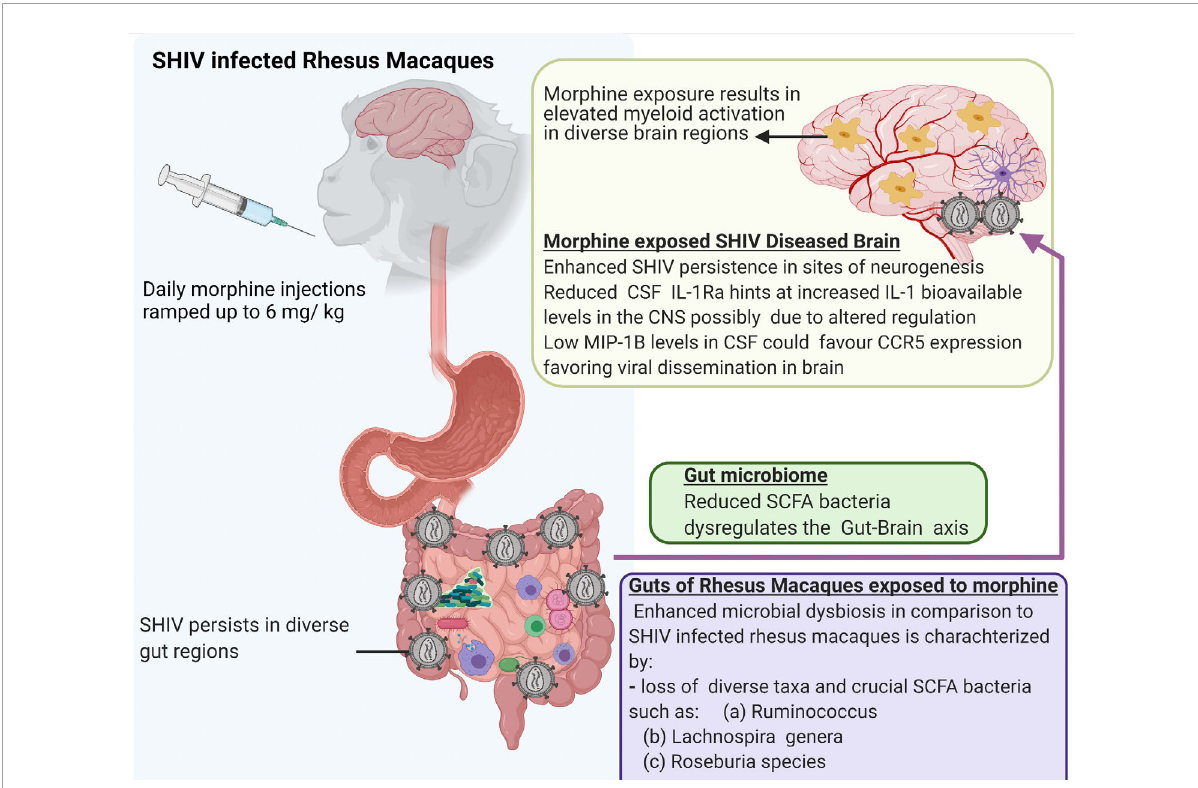
FIGURE8 Summary of multiple effects of morphine on the gut-brain axis of simian human immunodeficiency virus (SHIV) infected rhesus